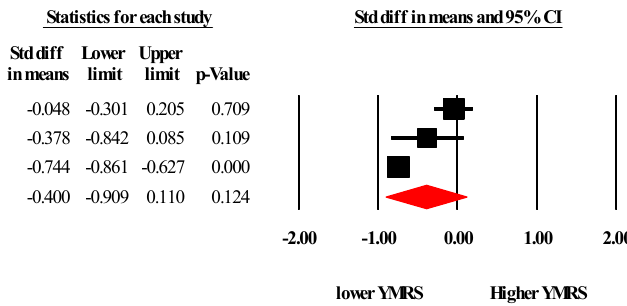
Figure 2. Forest plot of the Young Mania Rating Scale (YMRS) across the included studies.